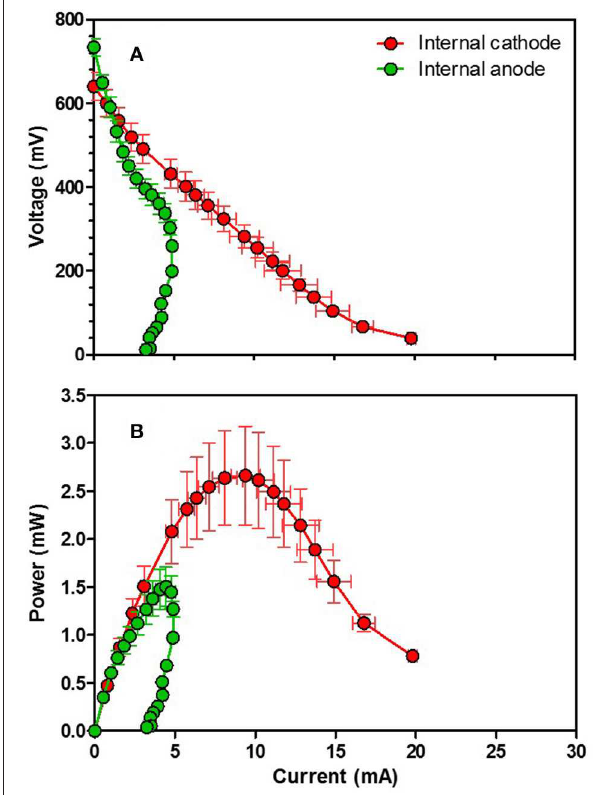
FIGURE 5 | Polarisation (A) and power curves (B) of Type 2 brick MFCs. Data points are average values of